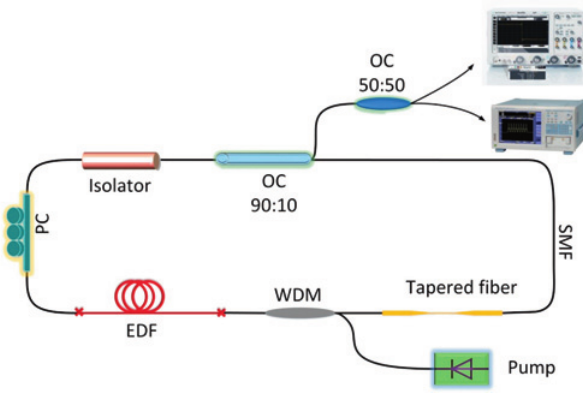
Figure 3: Experimental setup of the PML fiber lasers based on MXene V 2 CT x nanosheets as SA. EDF: Erbium-doped fi ber, PC: polarization